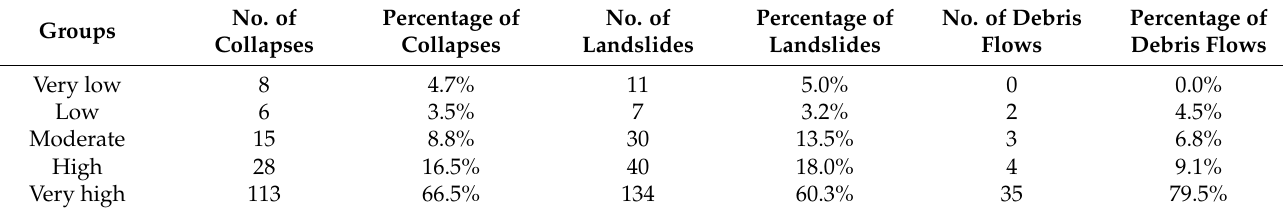
Figure 6. The basic geological hazard susceptibility maps: ( a ) Collapse susceptibility map, ( b ) land- slide susceptibility map, and ( c ) debris flow susceptibility map. Table 4. The sample statistical results of the basic susceptibility